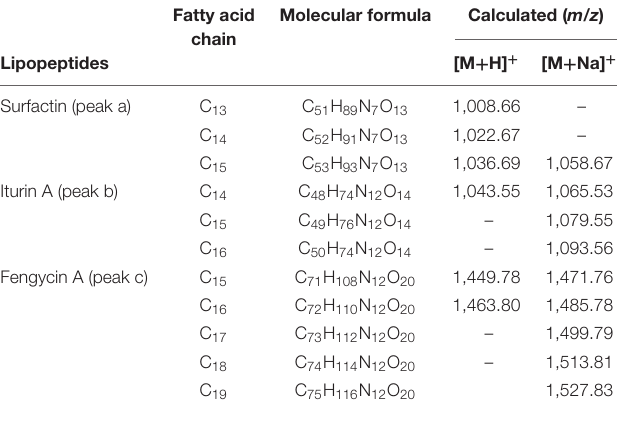
TABLE 2 | MALDI-TOF-MS/MS detection of purified CLPs. Fatty acid Molecular formula chain